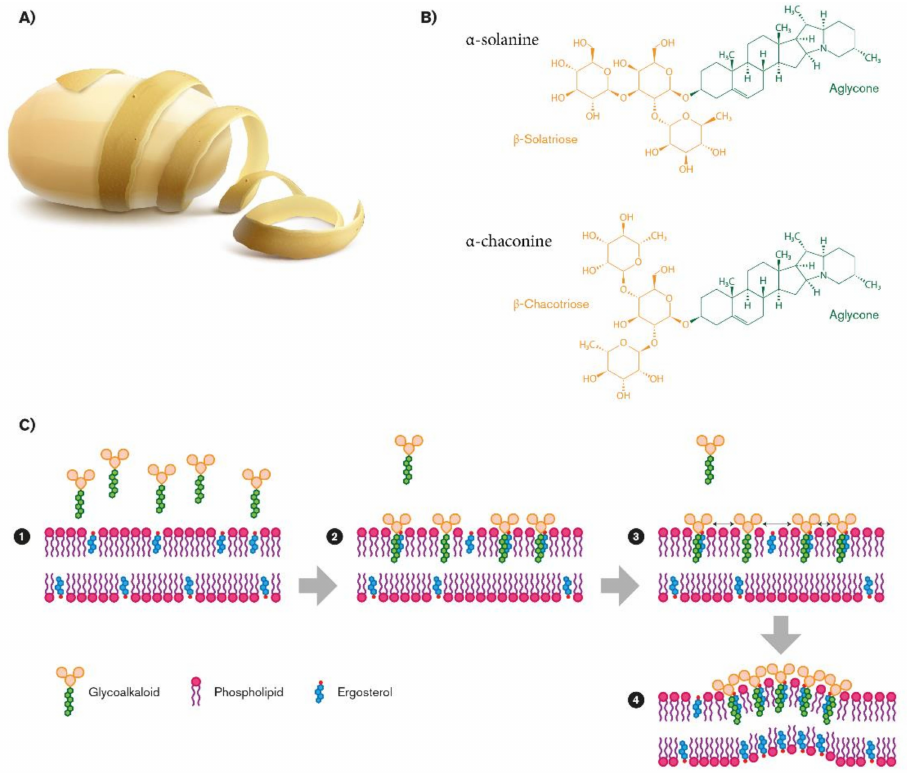
Figure 1. Biovalorization of glycoalkaloids α -chaconine and α -solanine from potato peel waste ( A ). Their chemical structures ( B ), and their role in fungal membrane disruption ( C